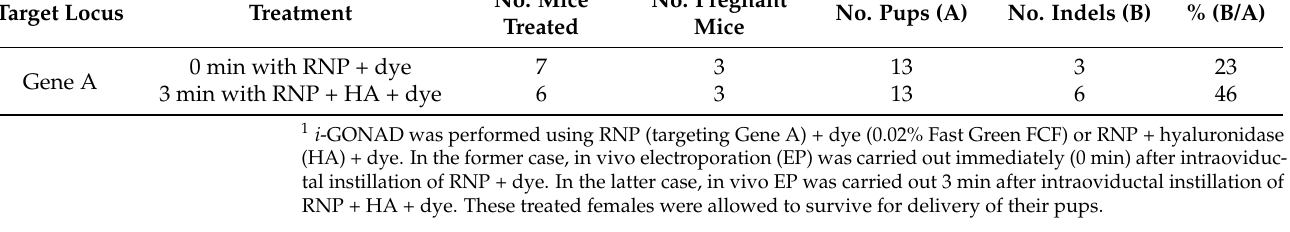
Table 1. i- GONAD 1 targeting Gene A at Day 0.5 of pregnancy (13:00 p.m.) using C57BL/6J mice.